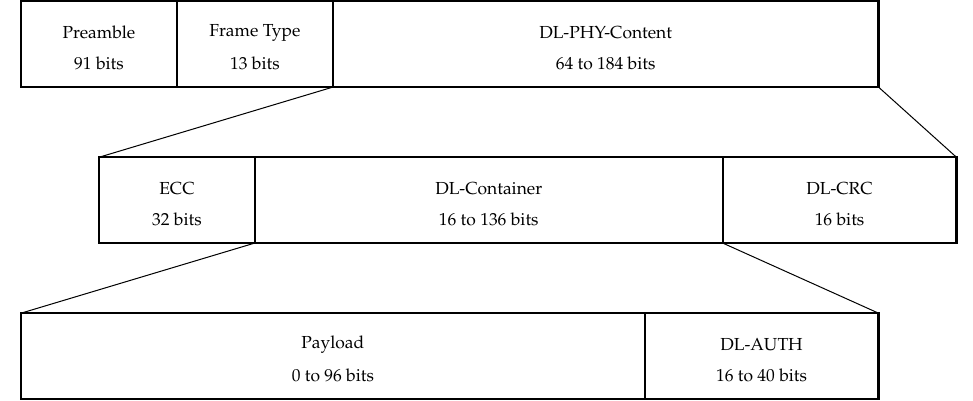
Figure 5. Downlink frame structure in